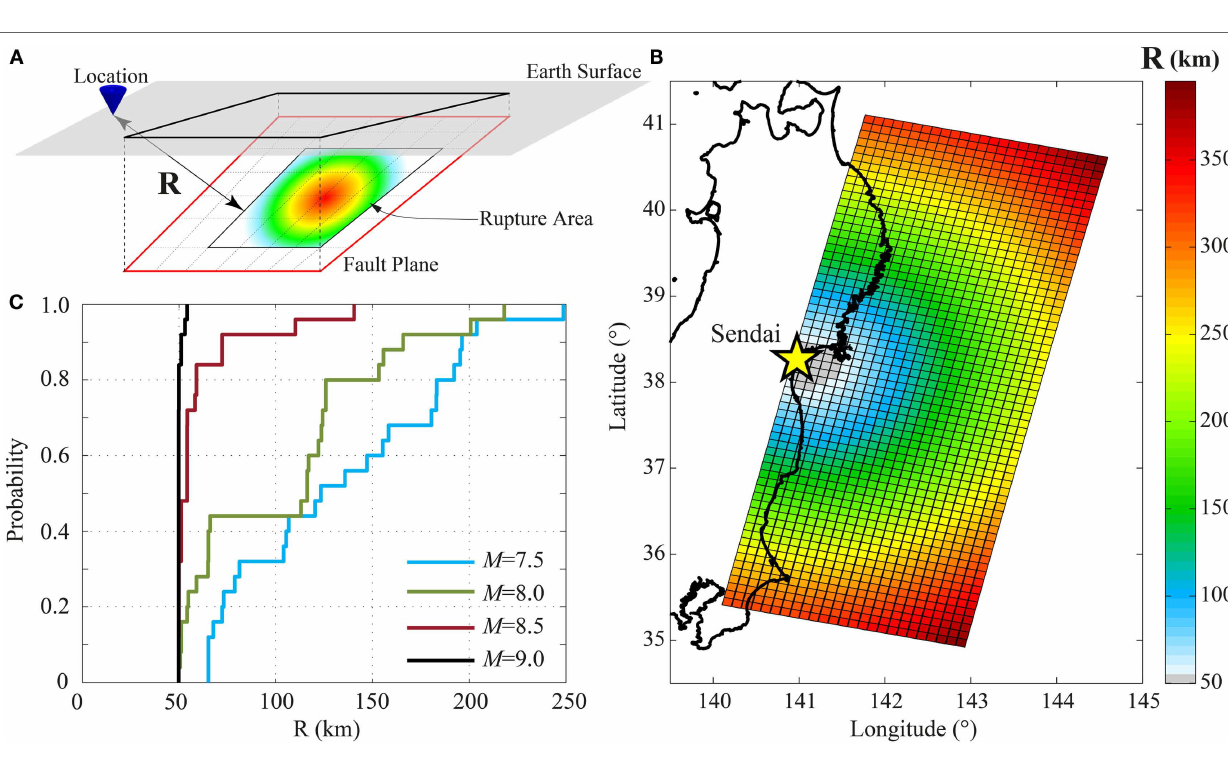
FIGURE 7 | (A) Schematic representation of the shortest distance from the rupture. (B) Precalculated distance for each sub-fault from a site in Sendai City. (C) Distribution of the distances for 500 stochastic simulations associated with 4 values of